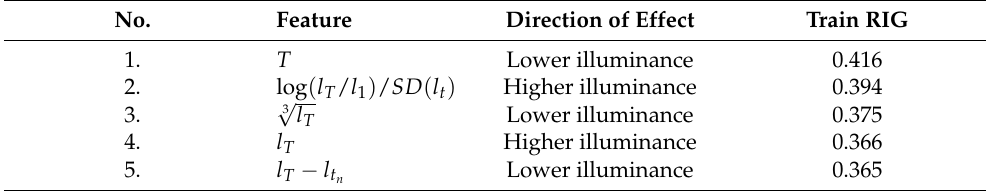
Table 1. The top five important features according to the relative information gain (RIG) score: The window size for the timestamp was determined by the training period, which was three days for the input and one day for the offset, and total data for a 4-day period. The illuminance value in this period could be listed in the set, l t : = { l t , l t , l t , . . . l t , l T } , where T was the last timestamp in the n 2 3 1 training phase and SD was the standard deviation. No.